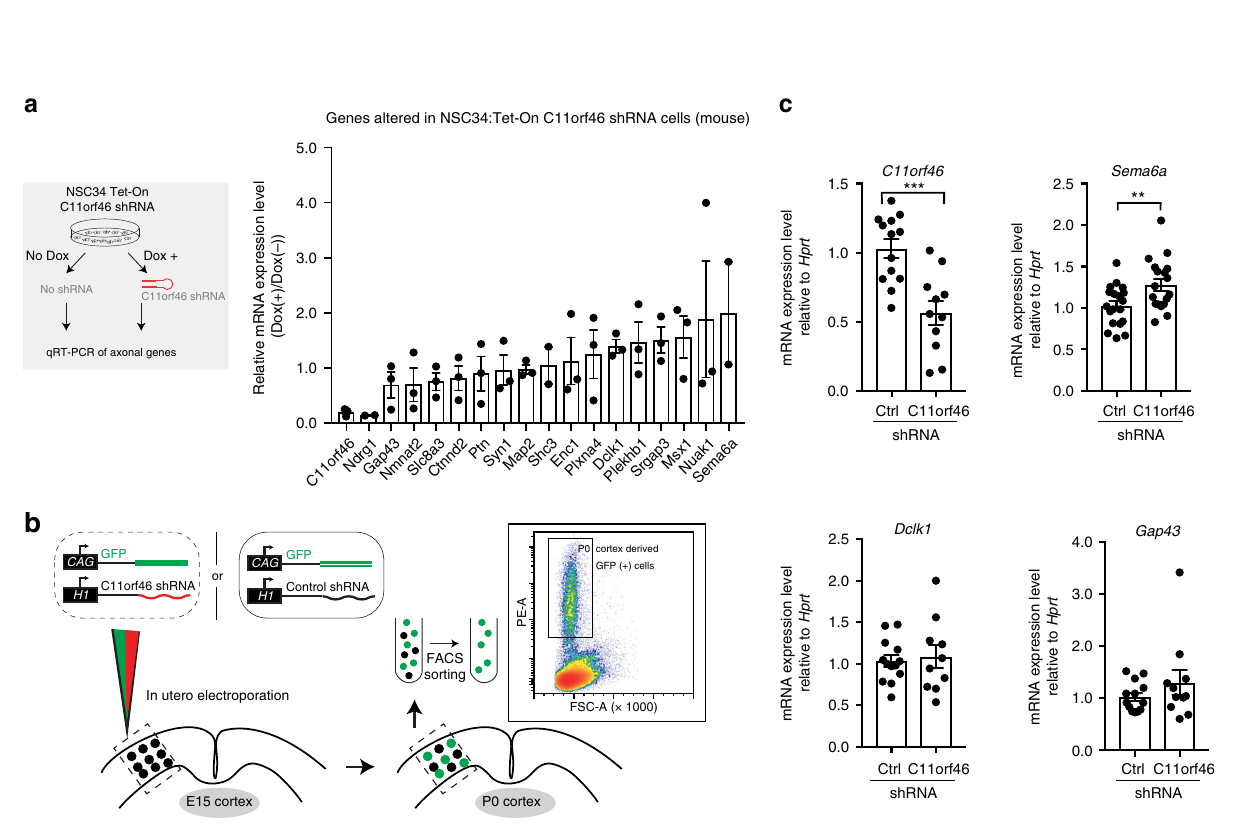
Fig. 4 Selection of targeted genes by C11orf46-SETDB1 complex. a Mouse neuroblastoma cells NSC34 inducibly expressing C11orf46 shRNA upon doxycycline addition (schematic in left panel); selected subset of 17 differentially expressed genes implicated in axonal growth and development was tested in RNA expressed from NSC34:Tet-On C11orf46 shRNA cell (right panel). b Neuronal progenitors received control or C11orf46 shRNA and GFP marker plasmids at somatosensory cortex by IUE at E15; four days later at P0 GFP-positive cells were collected by fl uorescence-activated cell sorting (FACS). c C11orf46 transcript levels were reduced by 50% in sorted GFP-positive cortical neurons electroporated with C11orf46 shRNA1 as compared to GFP- positive neurons with control shRNA (P = 0.0003). Note increase of Sema6a transcript upon C11orf46 knockdown ( P = 0.0085). * P < 0.05, ** P < 0.01, ** *P < 0.001 determined by Student ’ s t -test test. n = 10 – 19 independent mice per condition. All data were normalized by the Hprt transcript. Bar graphs indicate mean ± S.E.M ( a , c ) GFP expression plasmid at E15 and GFP-labeled projection neurons were isolated by fl uorescence-activated cell sorting (FACS) at P0 (Fig. 4b). Notably, Sema6a was signi fi cantly increased in C11orf46 knockdown projection neurons (Fig. 4c). Table 4). To con fi rm C11orf46 ’ s role as a transcriptional reg- These fi ndings, taken together, strongly suggest that C11orf46 regulates neuronal gene expression, including an inhibitory by IUE-mediated delivery of C11orf46 shRNA together with effect on Sema6a .